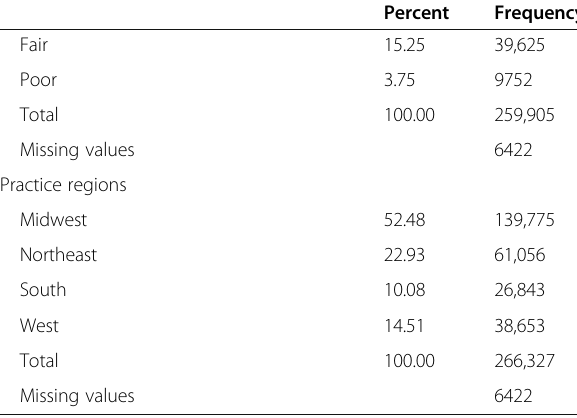
Table 1 Sample demographic information, CAHPS clinician and group adult visit survey 1.0